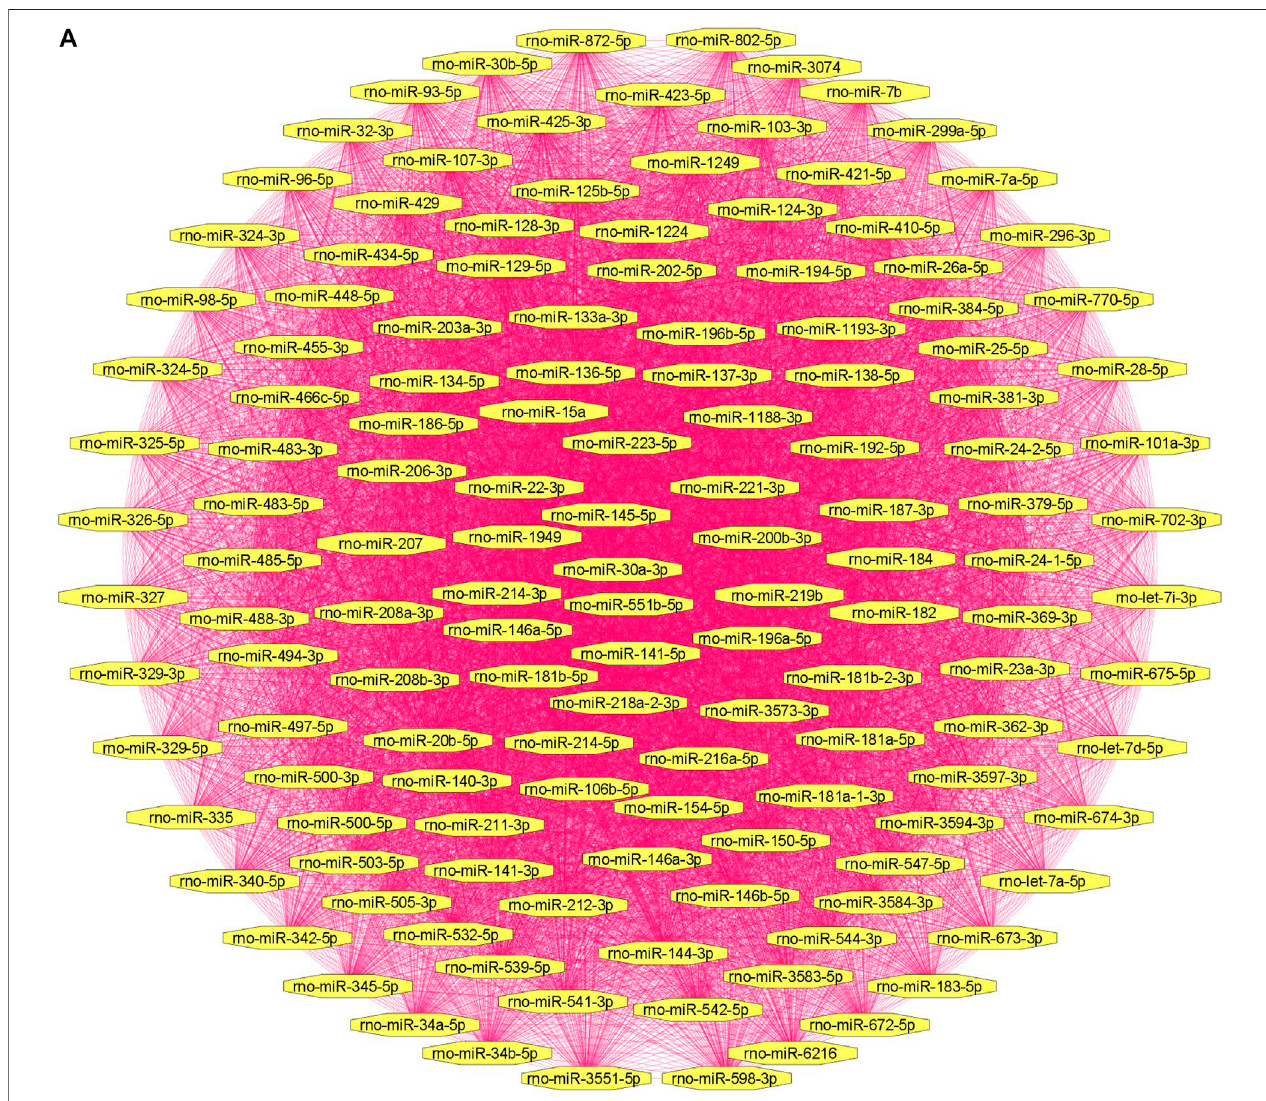
FIGURE6 | Downregulated rat microRNA networks in neuropathic pain: (A) Rat microRNA – microRNA network: Rat miRNA-miRNA interaction networkwith 140 nodes and 9,730 edges. The networks were constructed using Cytoscape 3.8.2. (B) Rat microRNA – gene target network: Architecture of networks of upregulated miRNAs in rats implicated in neuropathic pain showing interaction network of functionally enriched miRNAs with their targets with 239 nodes and 330 edges. The networks were constructed using Cytoscape 3.8.2. Using Mienturnet, the miRNA-target interactions were identi fi ed by TargetScan and the functionally enriched miRNAs were generated using the KEGG